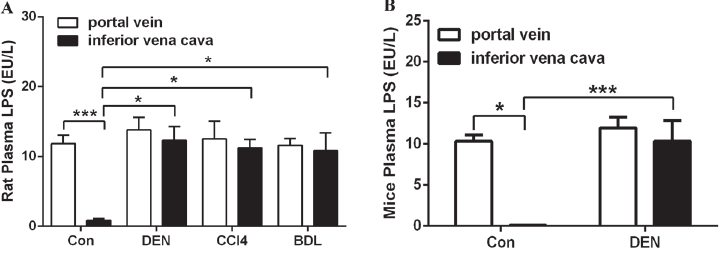
Fig 5. Plasma LPS levels in different rat and mouse models. Plasma LPS was determined in portal venous blood and inferior vena cava blood from normal rats and rats treated with DEN, CCl4 and bile duct ligation, as well as normal mice and DEN-treated mice. * p < 0.05, *** p <